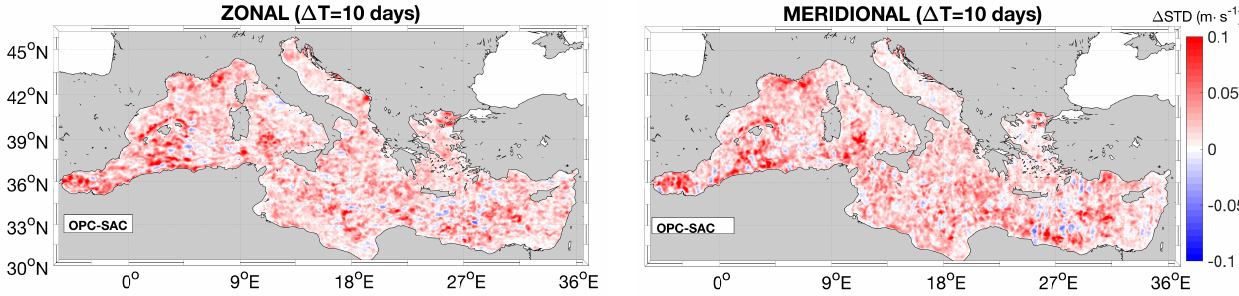
Figure 10. Differences between the OPC and the SAC temporal standard deviations ( ∆ STD) computed on a 10-day temporal window. ( Left ) and ( right ) panels stand for zonal and meridional currents,